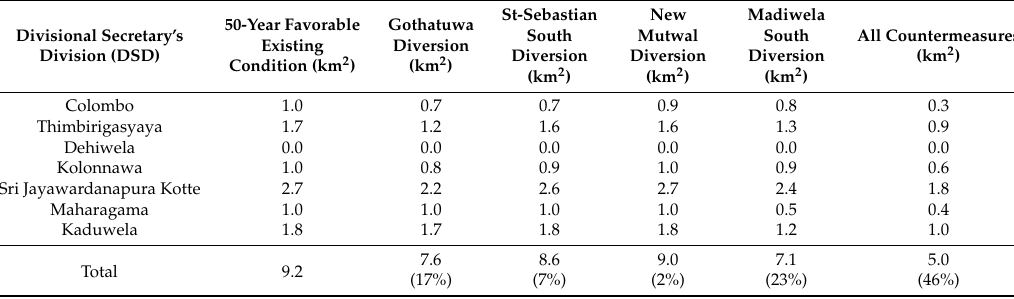
Table 7. Inundation area comparison for different countermeasures.